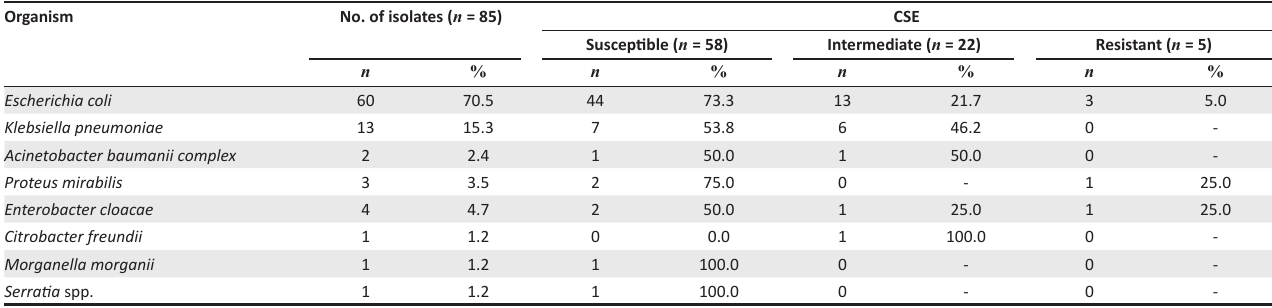
TABLE 2: Antibiogram for ceftriaxone-sulbactam-disodium edetate against extended-spectrum β -lactamases producing Gram-negative isolates at a hospital in Delhi, India, February 2017 to June 2017. Organism